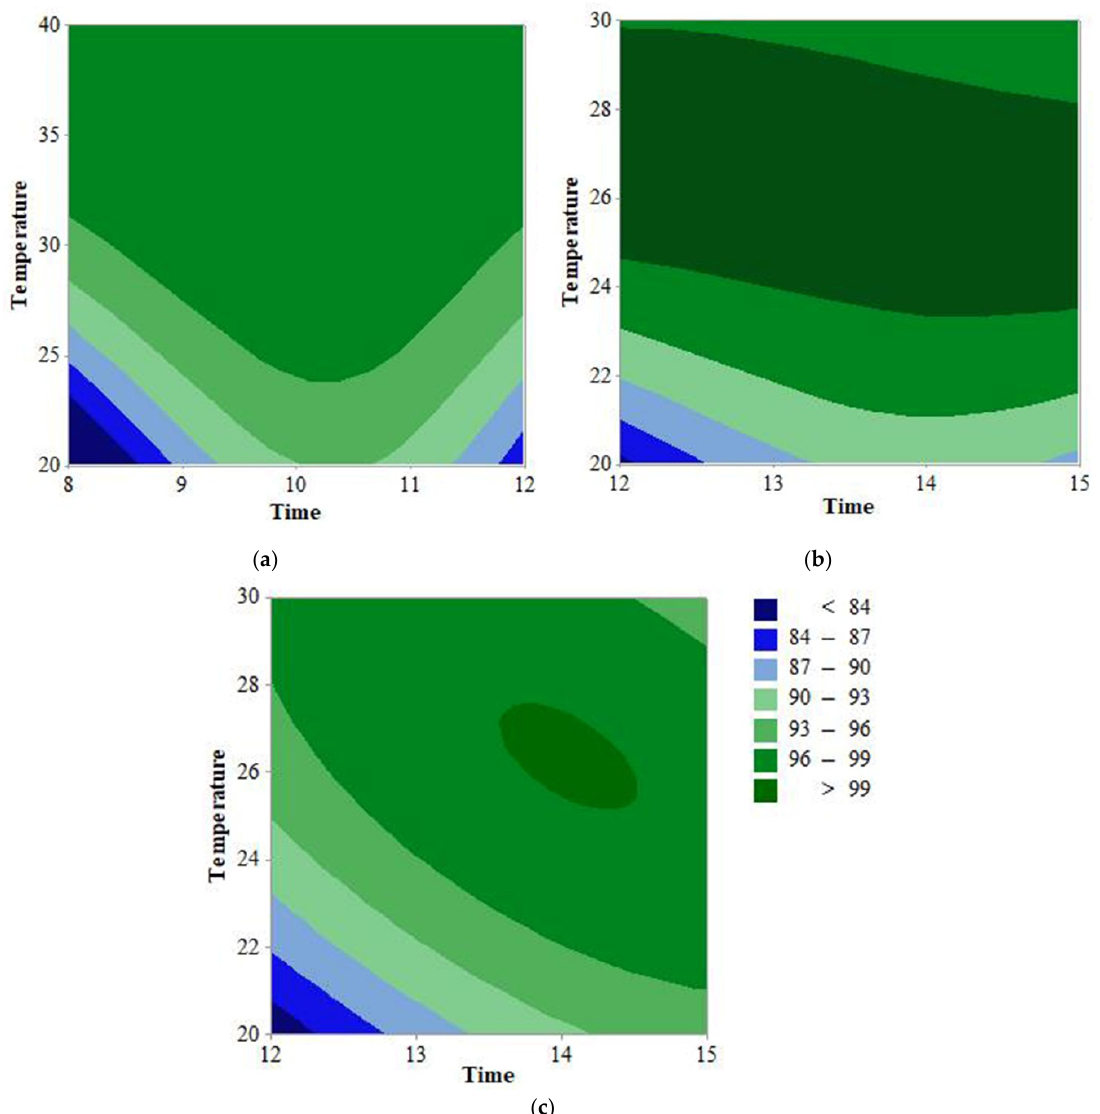
Figure 1. Response surface plots showing the effects of treatment time and cleaning temperature on stainless steel, rubber gasket, and PVC ATP removal rates (%) at an ACC of 50 mg/L. ( a ) Stainless steel; ( b ) Rubber gasket; (c) PVC.